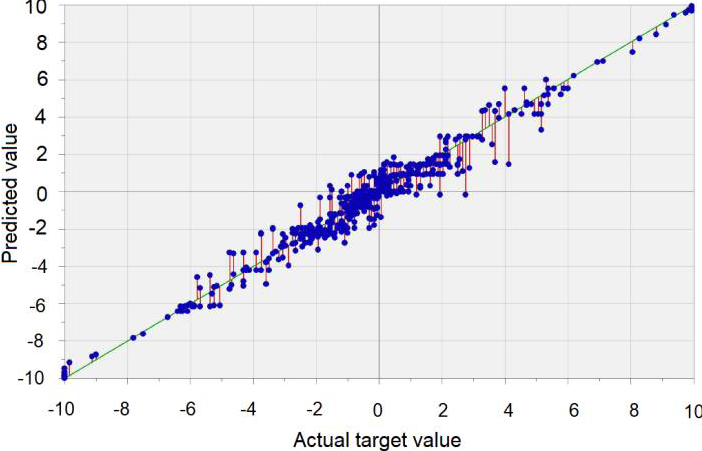
Figure 7. Predicted values (computed by the algorithm) vs. the recorded ones (voltage-V) (obtained using the DTREG software).